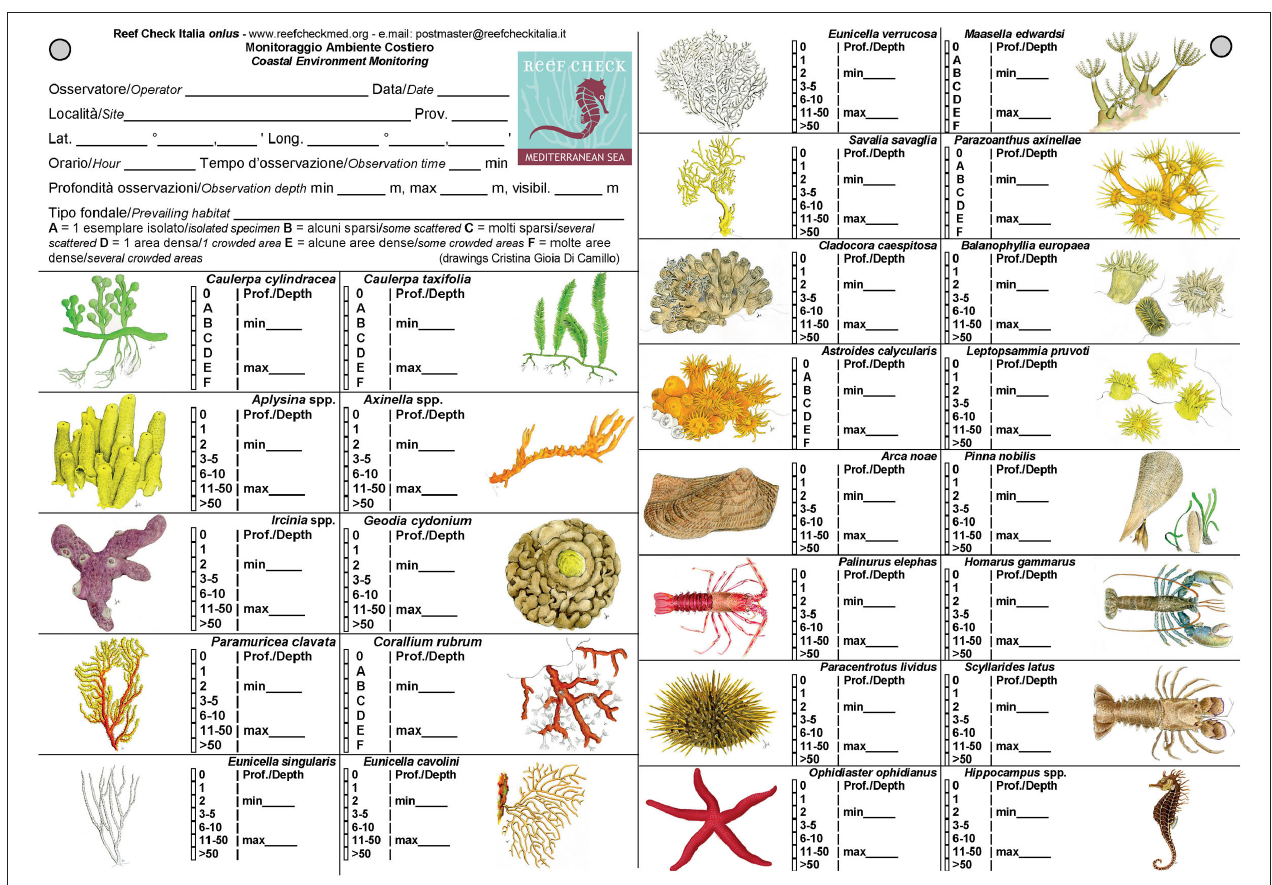
FIGURE 1 | Example of front and back of an underwater slate preset to record data according to the RCMed U-CEM protocol (Italian–English version with a subset of the most common target species on rocky